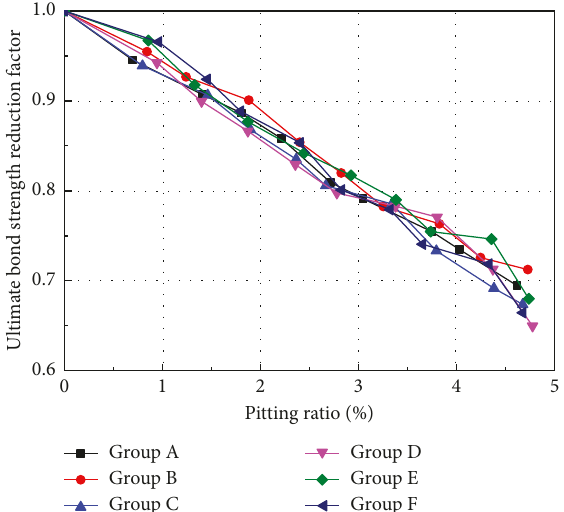
Figure 11: The relationship between the pitting ratio and bond strength reduction factor.